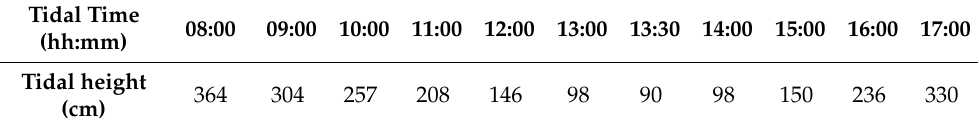
Table 2. Tidal chart of Jiaozhou Bay on 18 September 2019 1 .